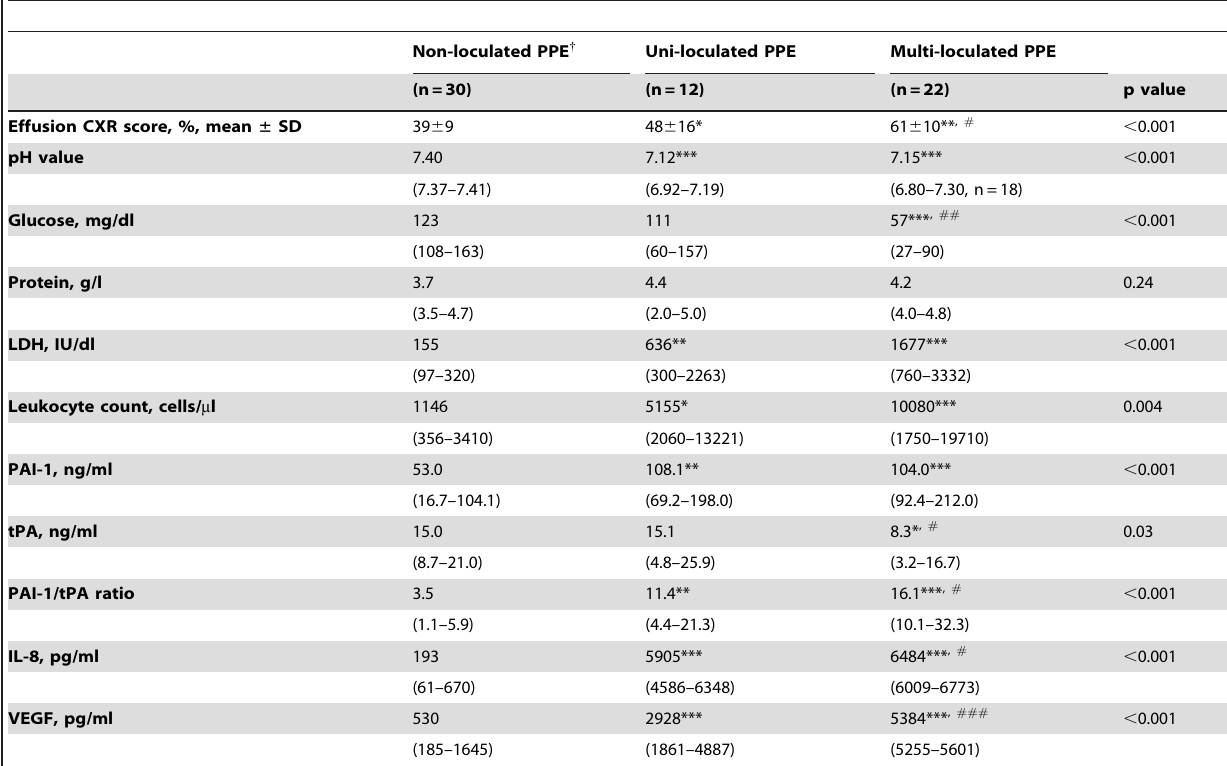
Table 2. Pleural Effusion Size and Variables between Non-, Uni- and Multi-loculated Parapneumonic Effusions (PPE).